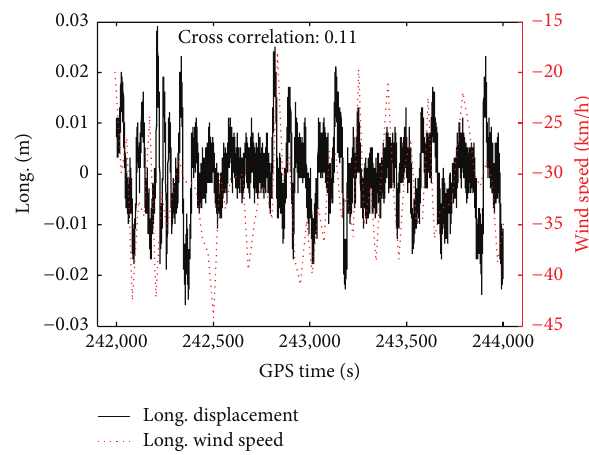
Figure 8: Longitudinal displacement and wind